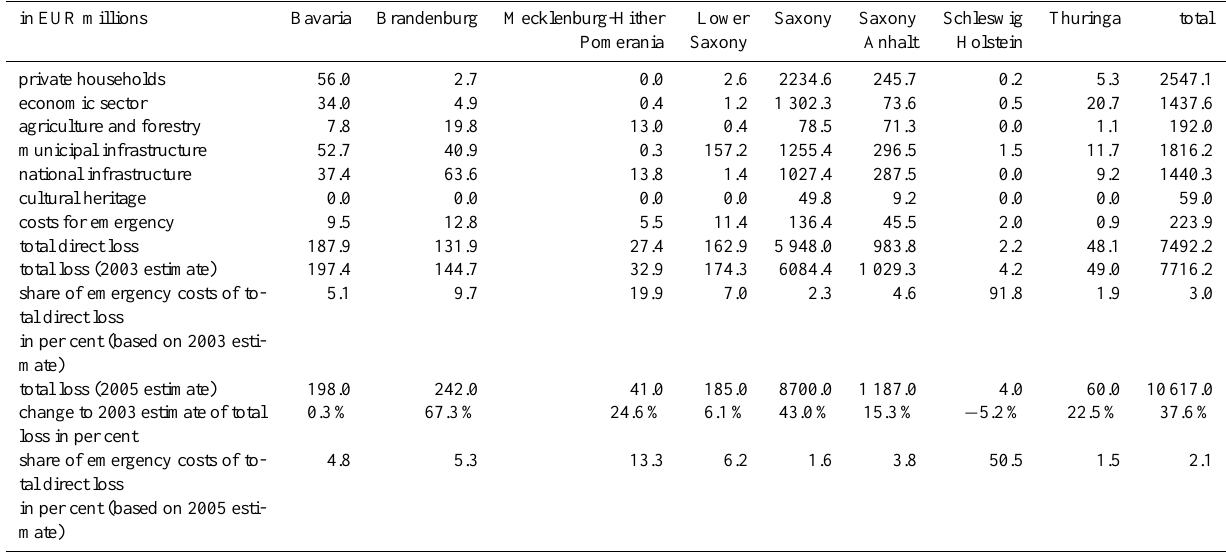
Table 4. Estimated loss data of the 2002 floods in the affected federal states of Germany without the figures for the national loss; source: estimates as at 2003 were reported to EU solidarity fund; estimates as at 2005 are based on IKSE 2004 and W. Kron, personal communication, 2011. in EUR millions Bavaria Brandenburg Mecklenburg-Hither Lower Saxony Saxony Schleswig Thuringa total Pomerania Saxony Anhalt Holstein private households 56.0